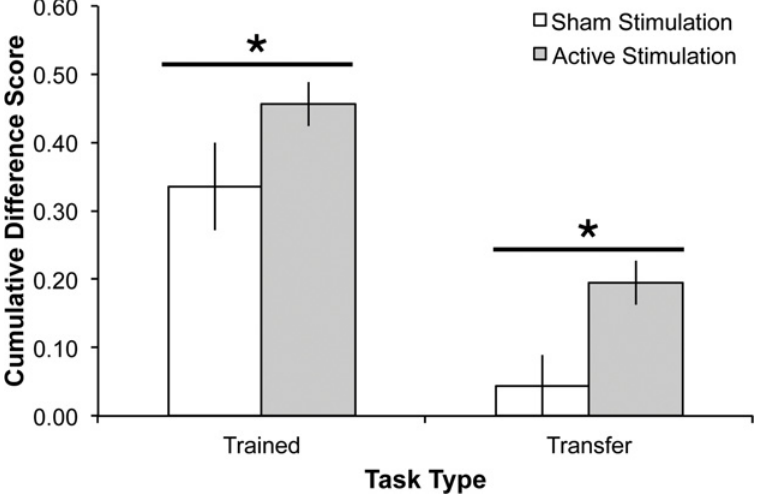
Fig 3. Combined benefit indices (follow-up compared to session 1) for the five trained and three transfer tasks for each stimulation group (active, sham). The active tDCS groups were collapsed across site because there was no significant difference between them. Error bars represent standard error of the